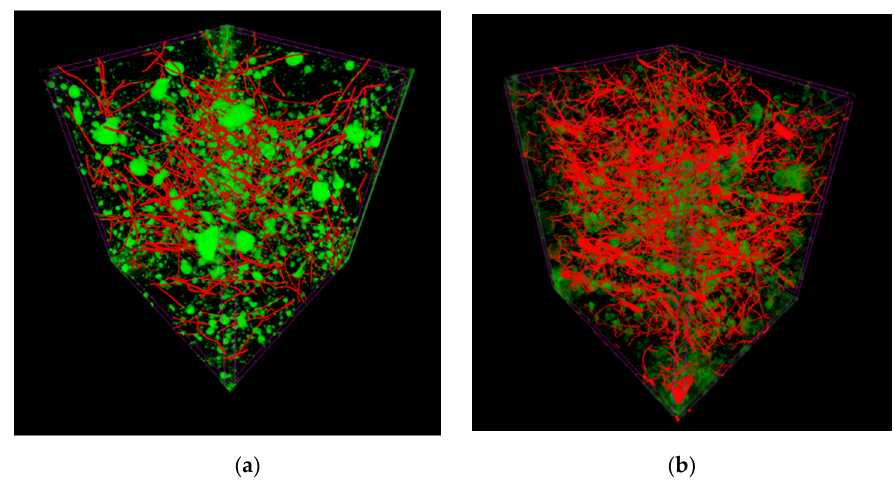
Figure 12. 3D computer micro-tomography image of SFRC ( a ) and RSFRC ( b ); fibre distribution (red): SFRC—0.32% and RSFRC 0.64%; and air pores (green): SFRC—2.76% and RSFRC 1.73%.